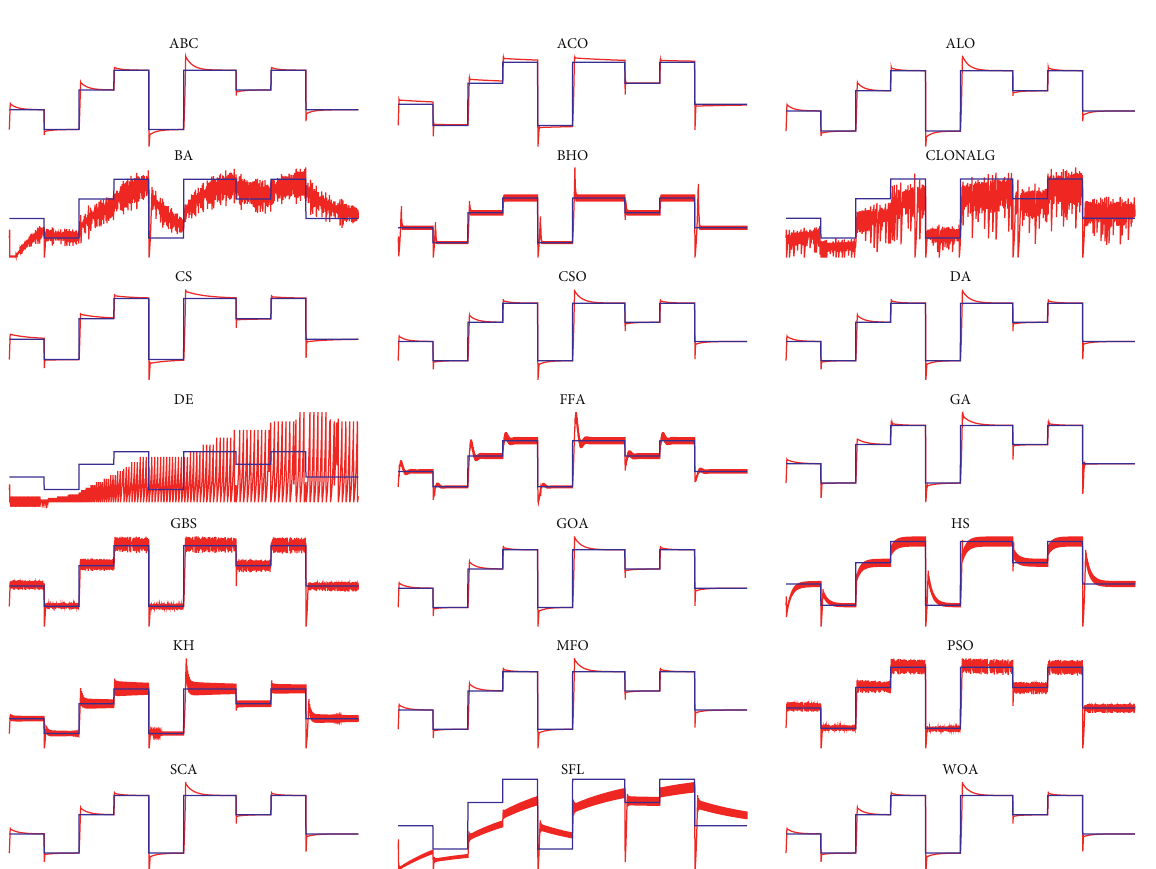
Figure 5: Results of 21 optimization metaheuristics using the mean square error as the fitness/objective function f output signal and the blue line is desired signal, see equation (1) and Table 5. Parameters have been set to the same values for all algorithms, 100 iterations, and a population size of 15 individuals with ( K p , K i , K d ) ∈ [ 0 . 001 , 100 ] , in order to get a similar testing environment for all algorithms.